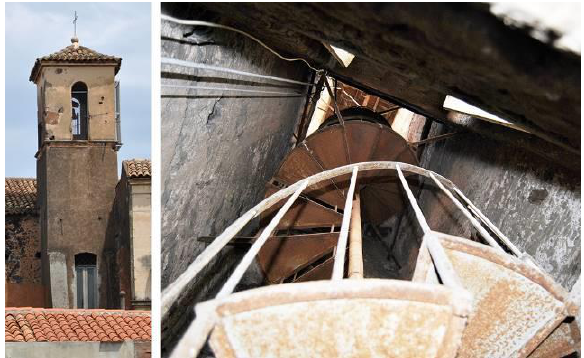
Figure 10. The bell tower of the SS. Crocifisso di Majorana in Catania. Iron spiral